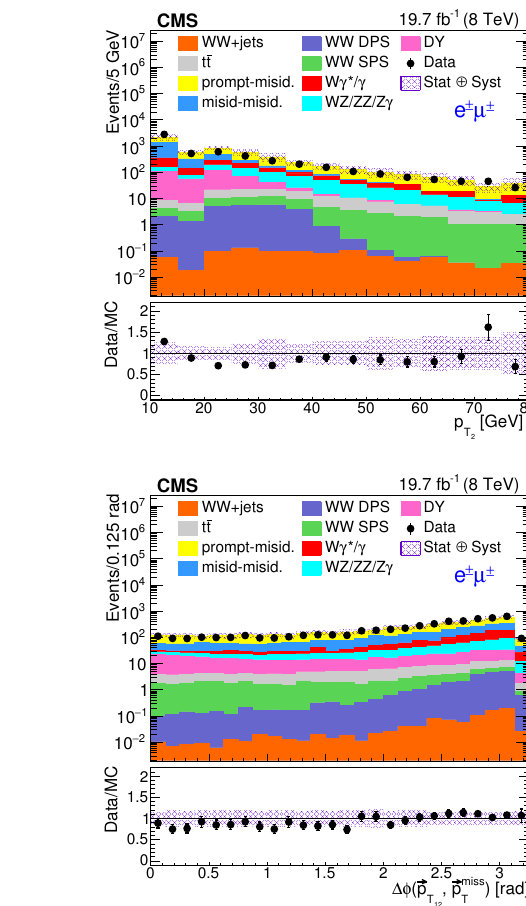
(top-left), p T (top-right), (cid:1) (cid:30) ( ~p T ; ~p miss ) (bottom-left), and T 1 2 2